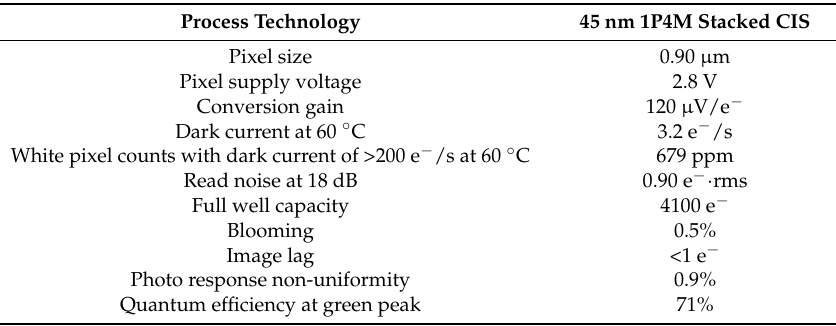
Figure 16. A sample color image taken with the 0.9 µm pixel manufactured in the 45 nm stacked CIS. Table 2. Sensor characteristics of the 0.9 µm pixel. Table 2. Sensor characteristics of the 0.9 µ m Table 2. Sensor characteristics of the 0.9 µm pixel.